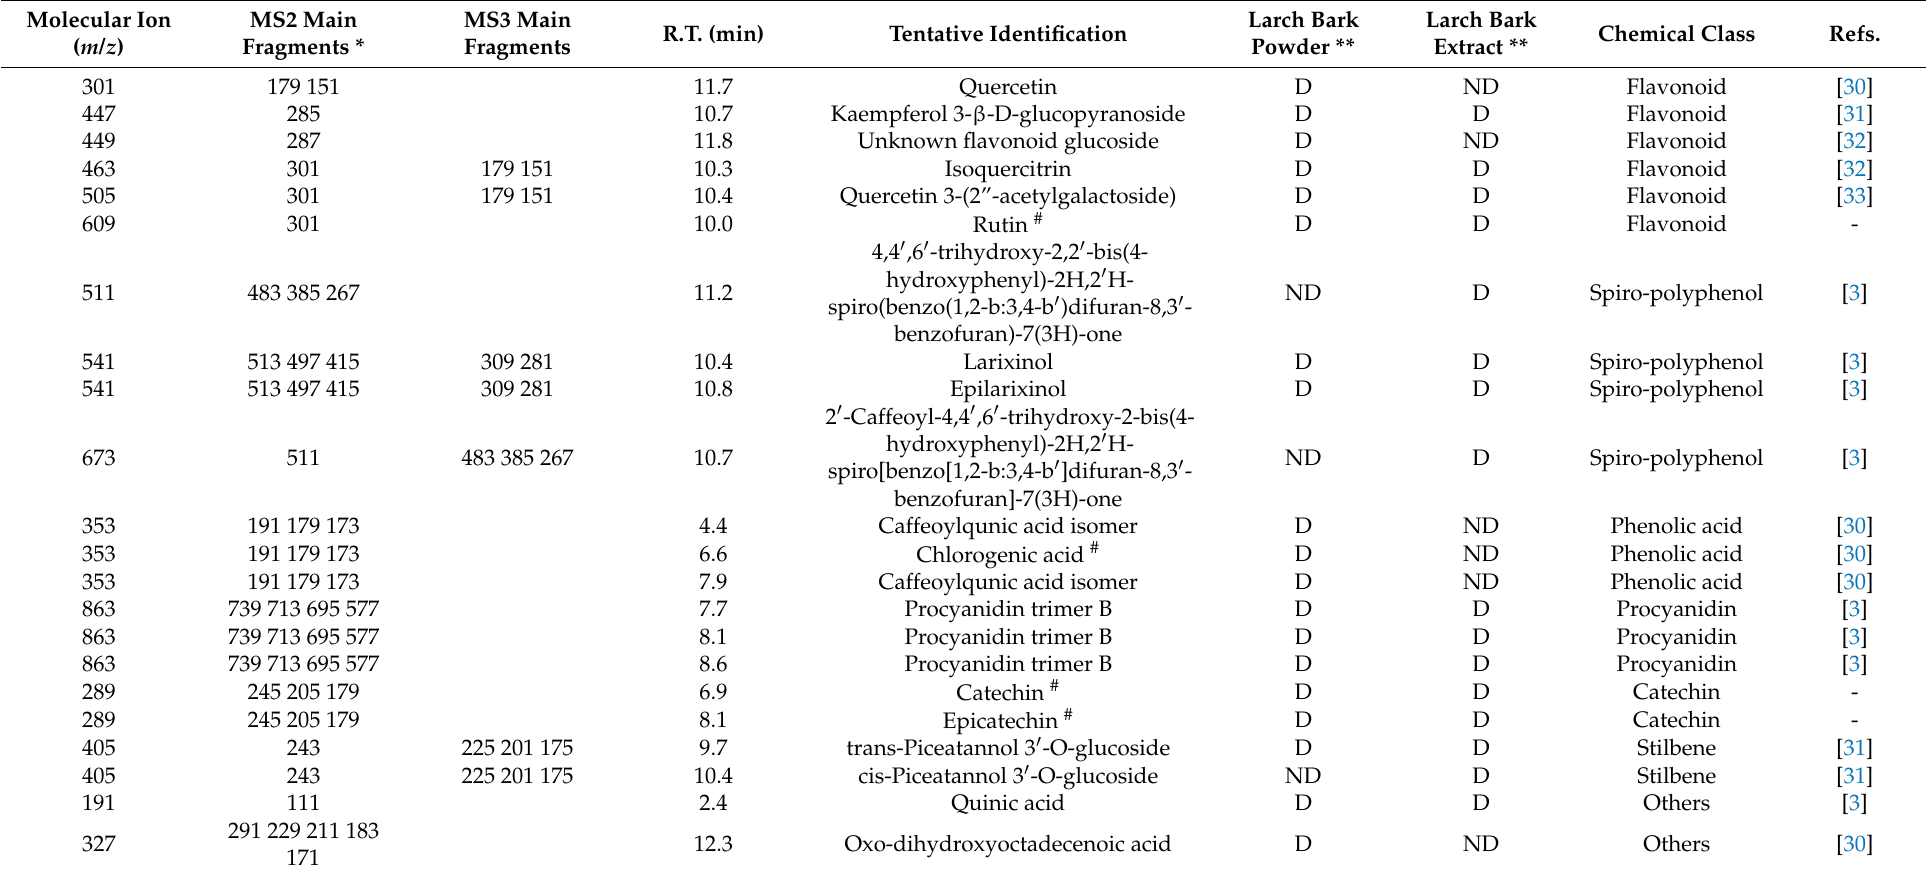
Table 4. Secondary metabolites tentatively identified in dry larch bark powder and in larch bark extract by HPLC-MS n